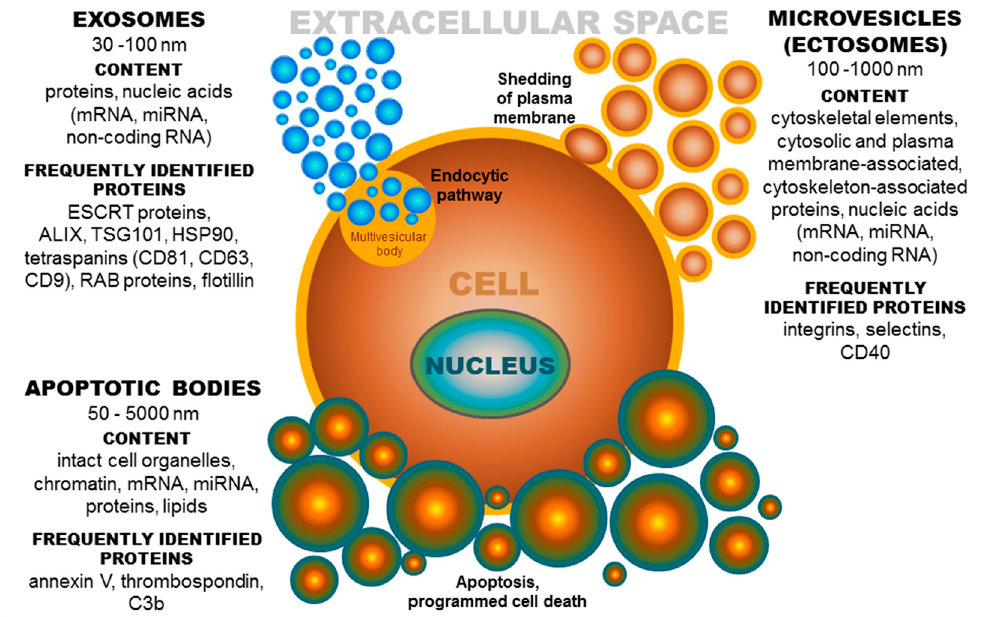
Figure 1. Extracellular vesicles: Their origin, size, and cargo. ESCRT—endosomal sorting complex required for transport; ALIX-protein regulating cellular mechanisms, including endocytic membrane trafficking and cell adhesion; TSG101—tumor susceptibility gene 101 protein; HSP—heat shock protein, CD—cluster of differentiation; RAB- proteins included in regulation of endocytosis and secretory processes, C3b—complement component.